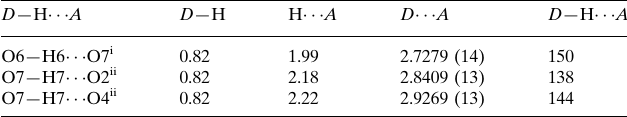
Hydrogen-bond geometry (A˚ , (cid:1)